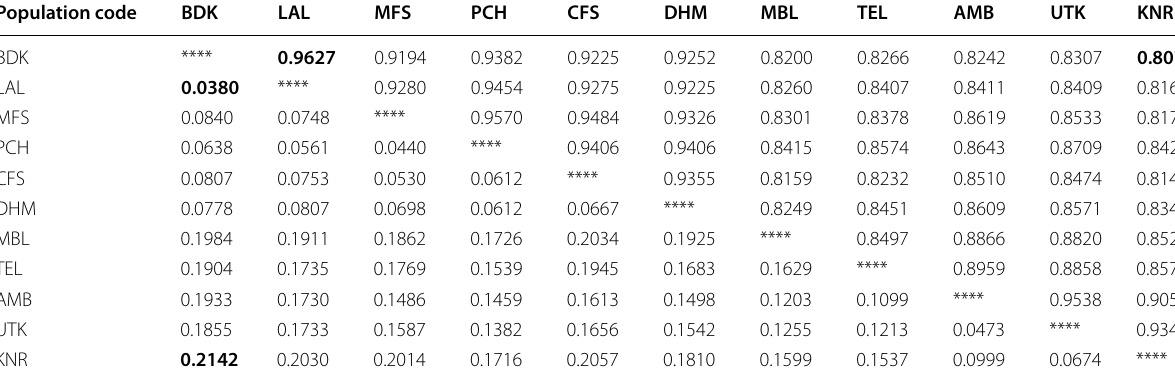
Nei’s genetic identity (above diagonal) and genetic distance (below diagonal). The maximum and minimum genetic identities and genetic distances are highlighted in bold. Population codes are as given in Table 1